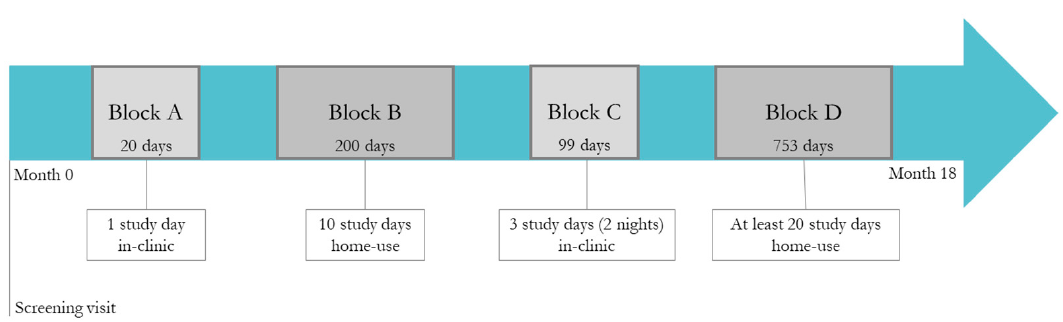
Figure 2. Schematic illustration of the study protocol. The study started with a screening visit at month 0 and ended after 18 months. Block A and C correspond to in-clinic sessions, while block B and D correspond to home-use of the device.